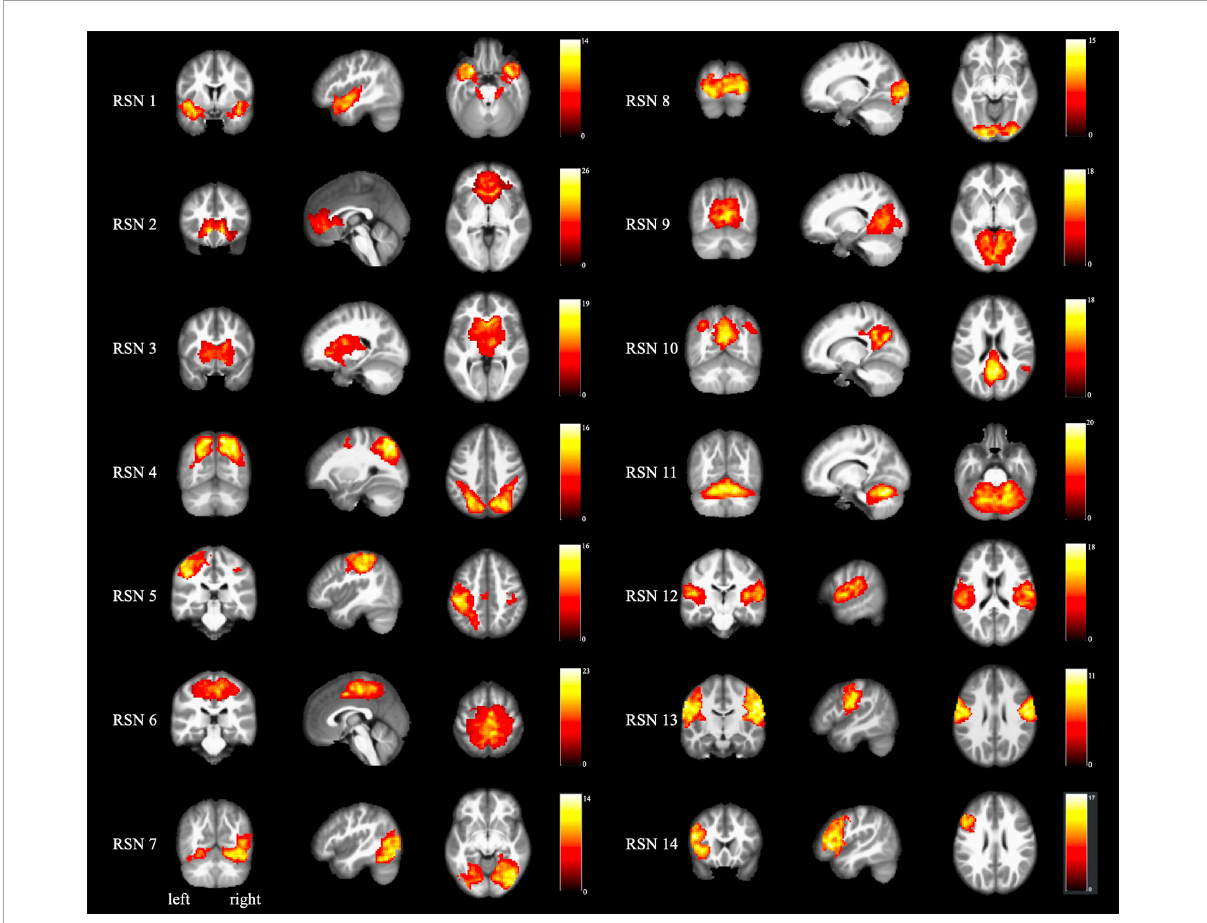
FIGURE1 Spatial maps for each RSN. Each RSN map was obtained using one-sample t -test across all individual independent components ( p < 0.05 after FDR correction). The color bar indicates the t -value of the one-sample t -test. RSN, resting-state